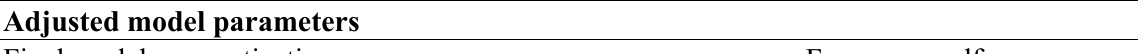
Table 1. Parameters of the final GLM model used to predict the fraction of water cover in a 30 m pixel from Landsat TM and ETM+ normalized reflectance. F-value, degrees of freedom (df) and p-value are shown. We tested as potential predictors the normalized reflectance of each spectral band (Band, B) and its value correcting for its reflectance in the absence of water (Corrected band,